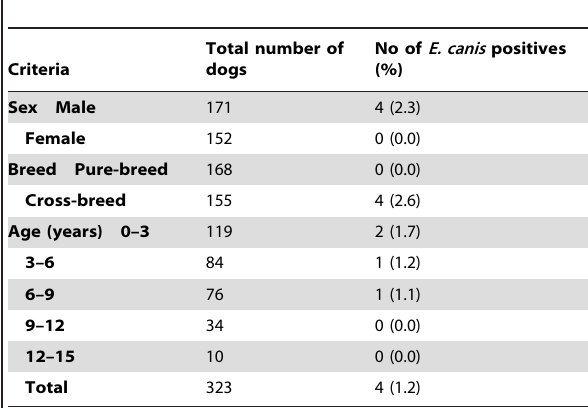
Table 1. Summary of prevalence of E.canis among clinic cases based on sex, breed and